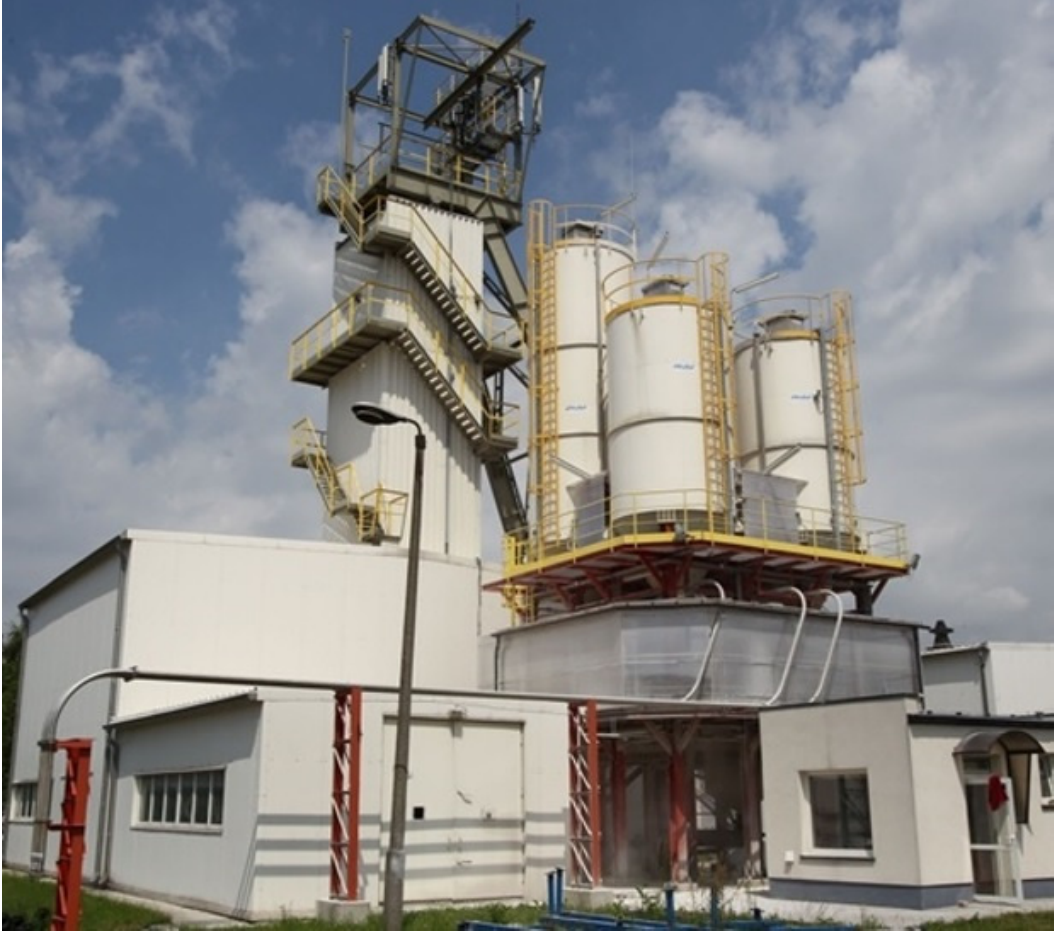
Figure 6. Injection node [9].